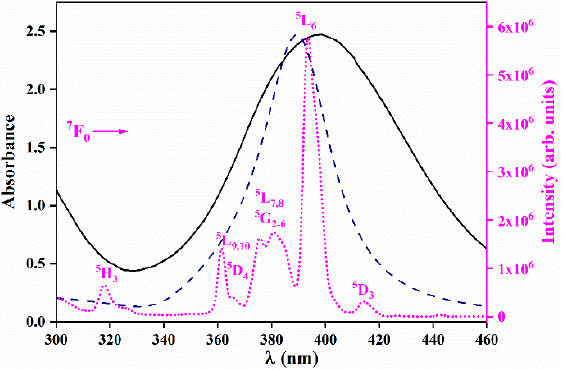
Figure 5. Ag NPs’ plasmonic absorption (black solid line) and the theoretical extinction efficiency curve for the 6 nm spherical Ag particles in water (blue dashed line), overlapping with the excitation spectrum of the LPO–Ag0.6 representative sample ( λ em = 611nm, pink dotted line).